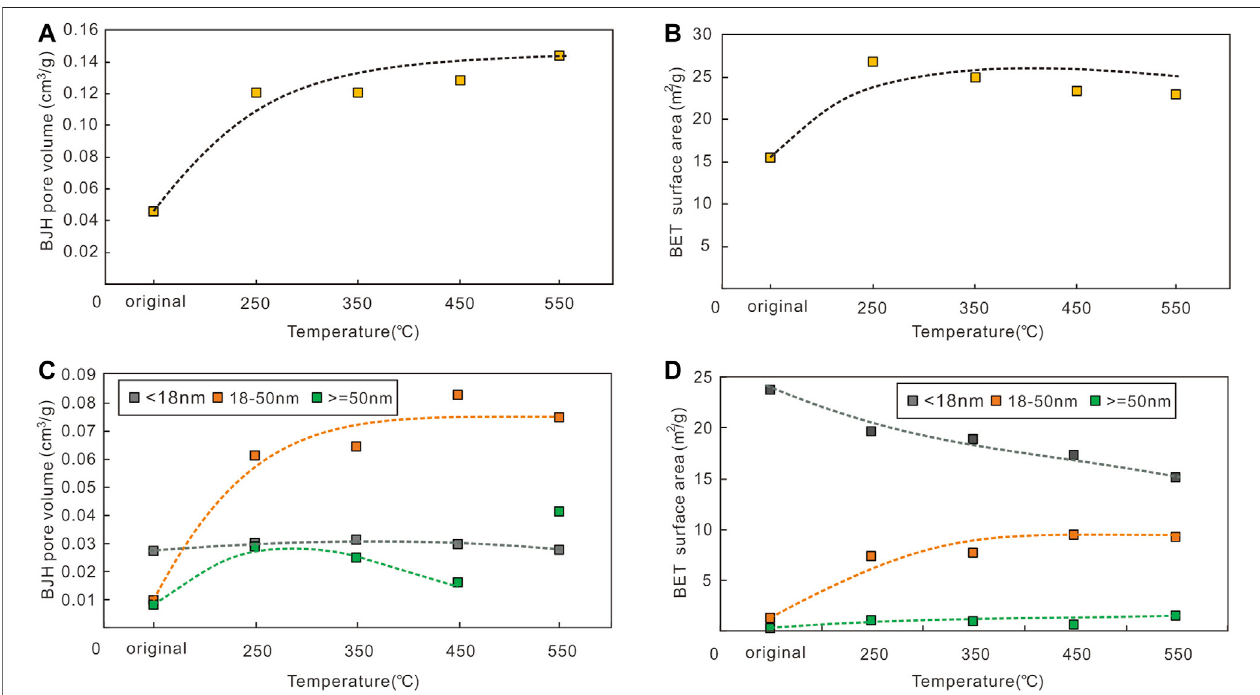
FIGURE 9 | Cumulative BJH pore volume and cumulative BET surface area characteristics of samples at different temperatures. A\C-Temperature vs BJH pore volume, B\D-Temperature vs BET surface area.